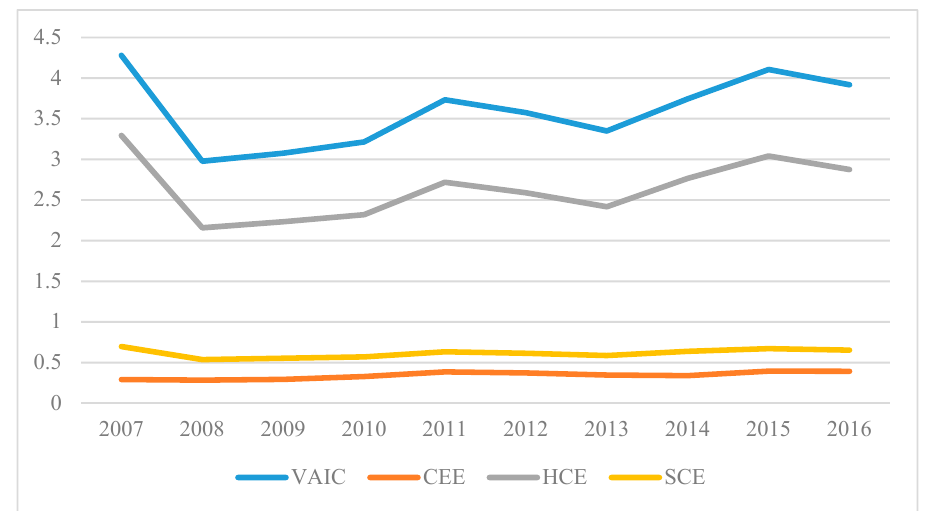
Figure 2. The trend of VAIC and its components (CEE, HCE, and SCE) from 2007 to 2016. Source: compiled by authors.